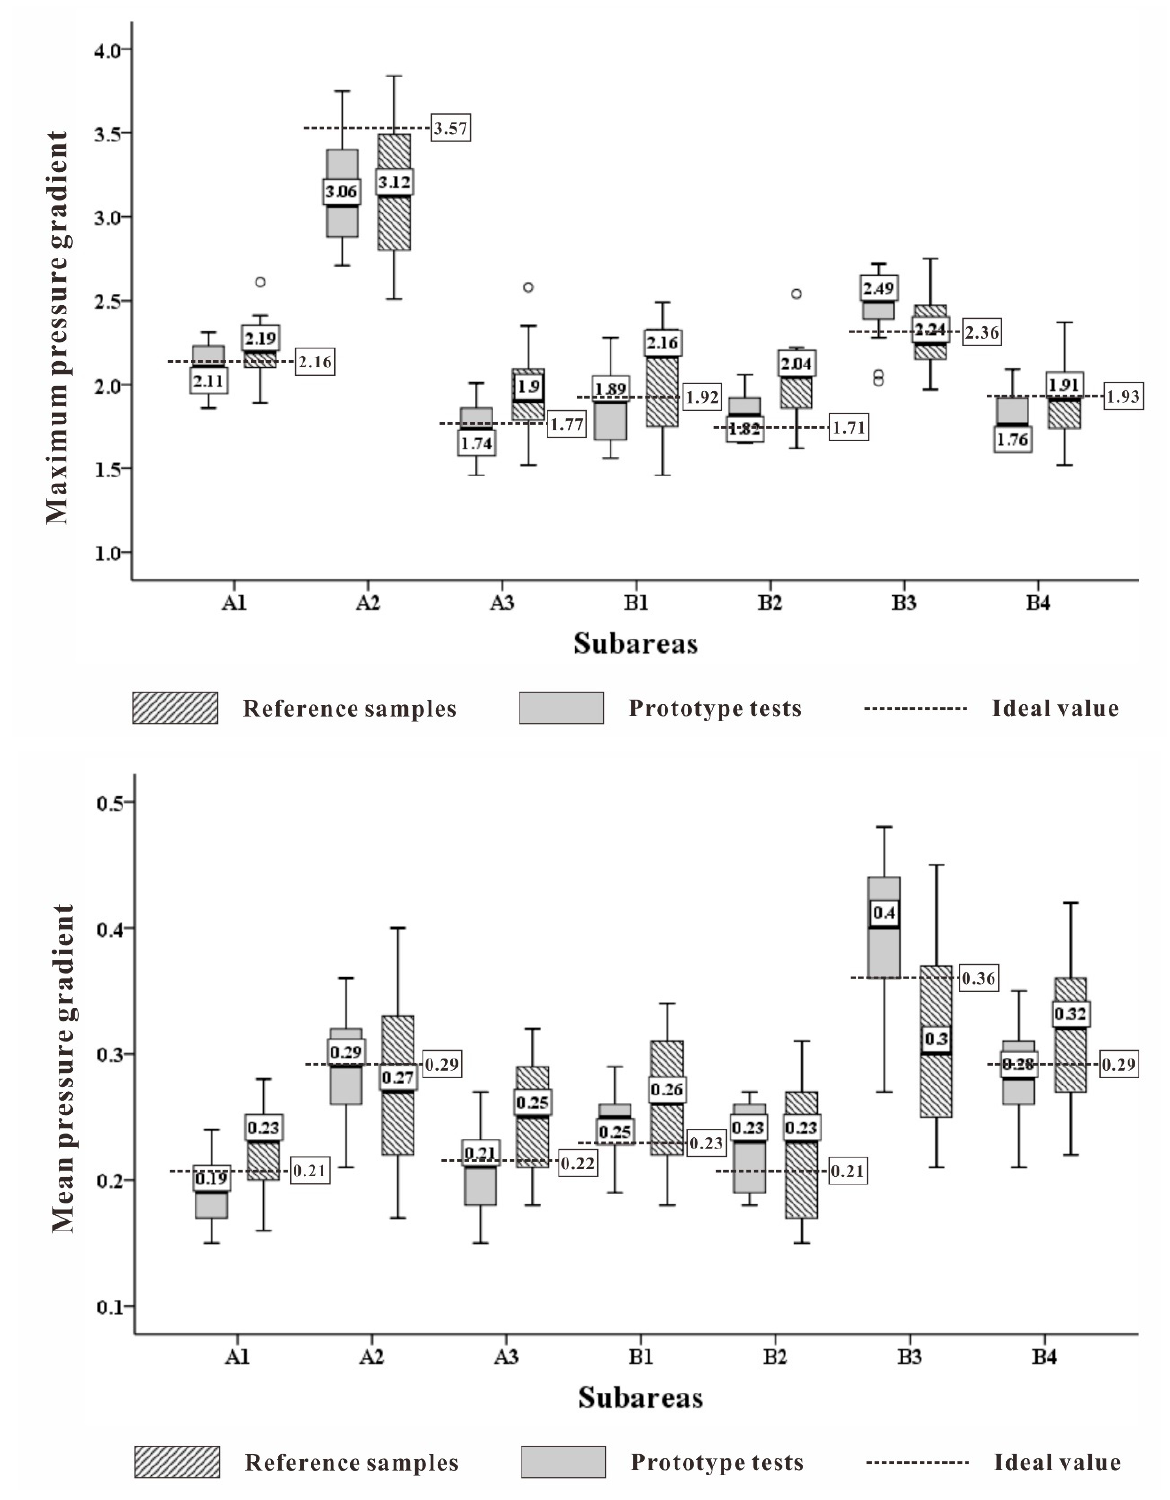
Figure 12. Comparison of body pressure distribution indicators in each partition of the four groups. In addition to restoring the ideal body pressure indicators in each partition, the similarity of the pressure distribution matrix is also an important basis for evaluating whether the prototype has restored the ideal support surface. The matrix similarity is calculated by Equation